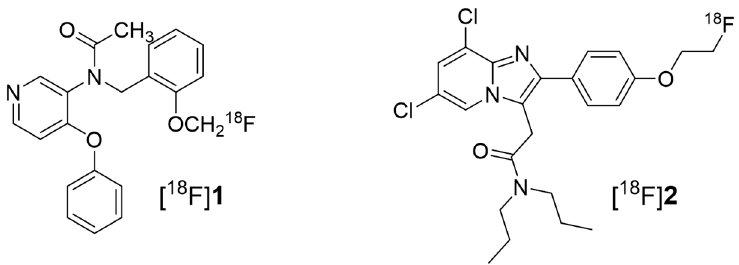
Figure 1. Structure of the 18-kDa translocator protein (TSPO) radiotracers [ 18 F]fluoromethyl-PBR28 for [ 18 F] 1 and [ 18 F]CB251 for [ 18 F] 2 .